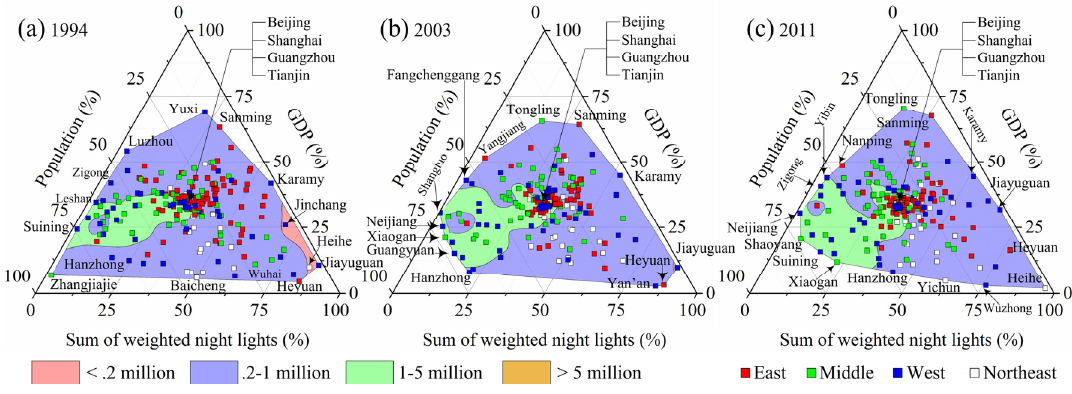
Figure 6. Ternary plots with contours of population sizes of China’s cities in 1994 ( a ), 2003 ( b ) and 2011 ( c